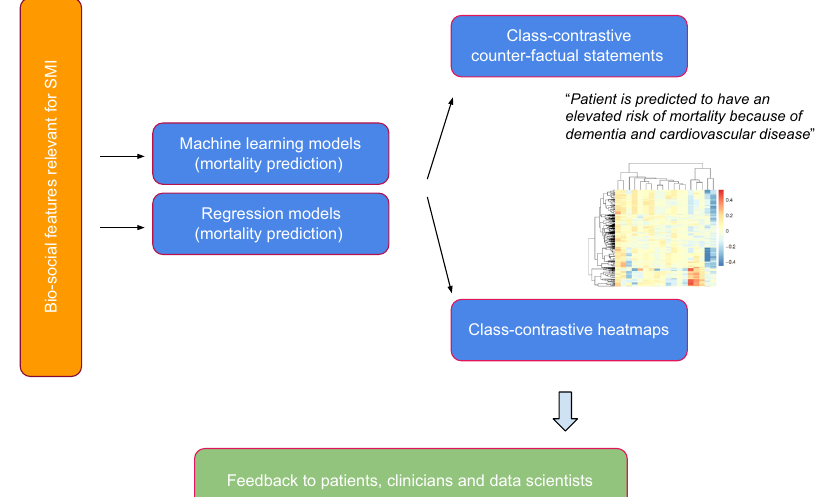
Fig. 1 Overview of approach. Bio-social factors that are relevant in severe mental illnesses (SMI) are derived from the electronic healthcare record system and used as inputs to statistical and machine learning algorithms. The algorithms are made interpretable using class- contrastive reasoning. The class-contrastive textual statements and heatmaps aid the understanding of models by domain experts such as clinicians, patients, and data